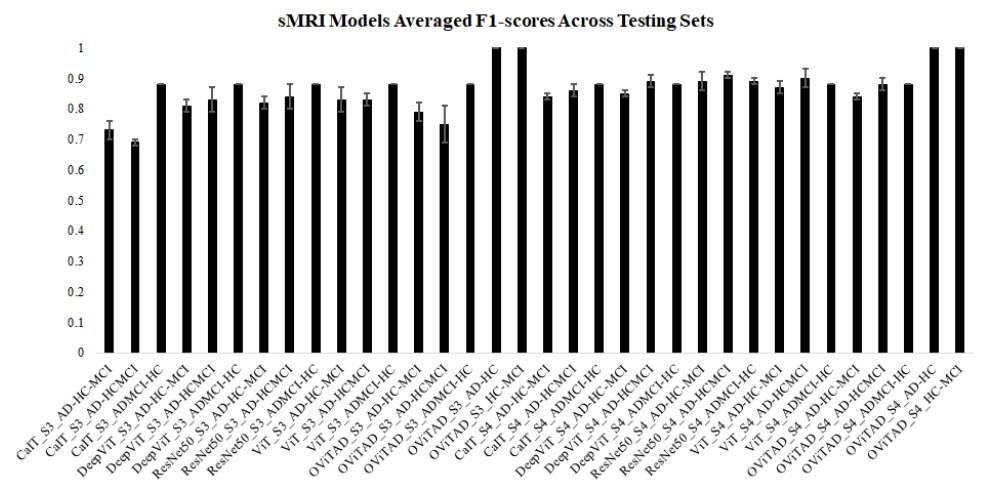
Figure A6. The summary of sMRI models’ performance (S3,S4) using averaged F1-scores for three testing